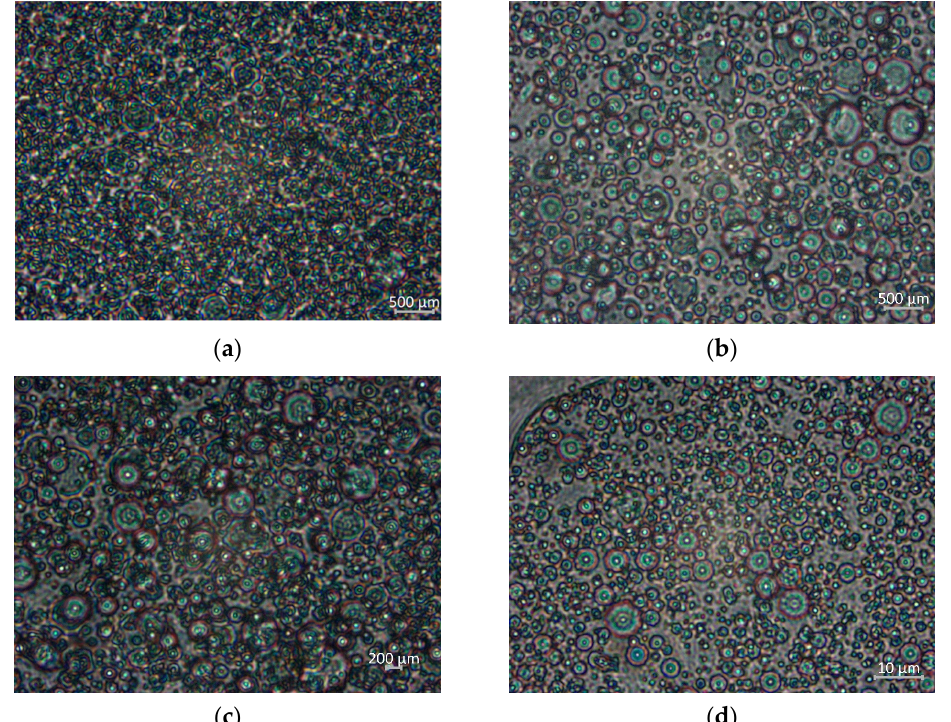
Figure 2. The microscopy properties of the emulsion sauce were evaluated at 100 × . ( a ) ES1, ( b ) ES2, ( c ) ES3, and ( d ) ES4.